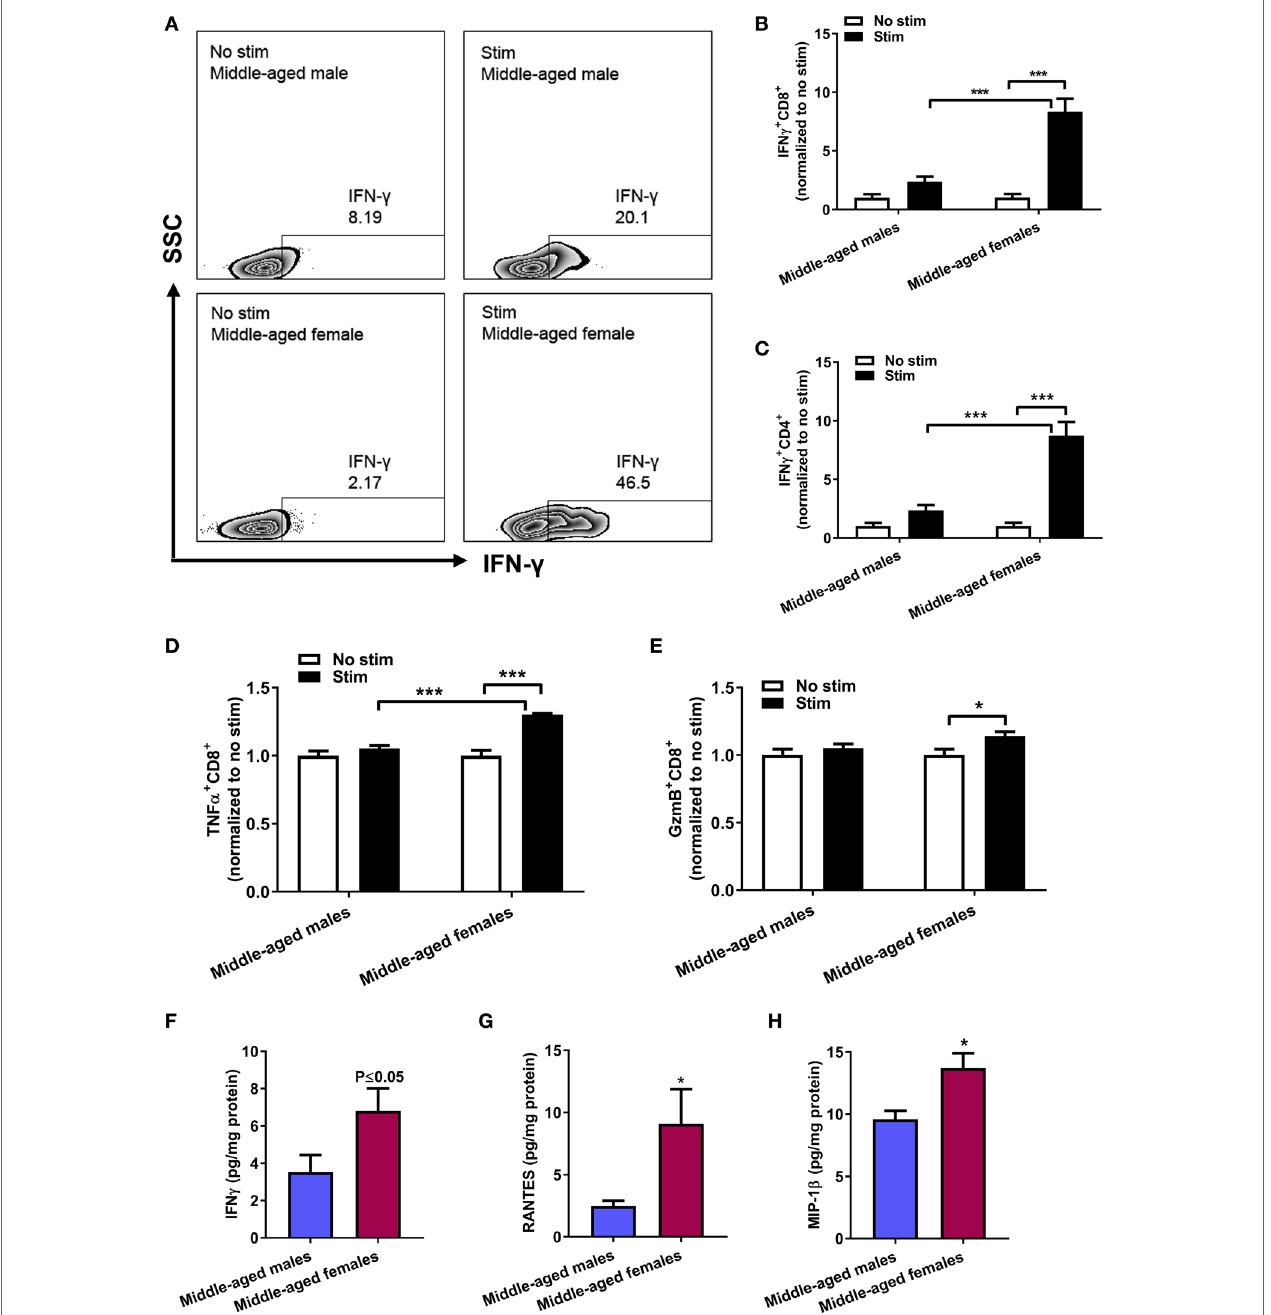
FigUre 3 | Sex differences in adipose CD8 + T-cell cytokine production ex vivo and total adipose cytokine levels. (a) Representative contour plots of IFN- γ + CD8 + T cells after ex vivo stimulation with phorbol 12-myristate 13-acetate and ionomycin for 4 h at 37°C 5% CO 2 . Quantification of (B) IFN- γ + CD8 + T cells, (c) IFN- γ + CD4 + T cells, (D) TNF- α + CD8 + T cells, and (e) Granzyme B (GzmB) + CD8 + T cells normalized to no stimulation conditions within each sex. Two-way ANOVA, * p < 0.05, *** p < 0.001 Sidak’s multiple comparison’s test, n = 5. Total adipose levels of (F) IFN- γ , (g) RANTES, and (h) MIP-1 β in middle-aged mice by multiplex cytokine measurement. p ≤ 0.05 unpaired t -test, * p < 0.05 unpaired t -test with Welch’s correction, n =